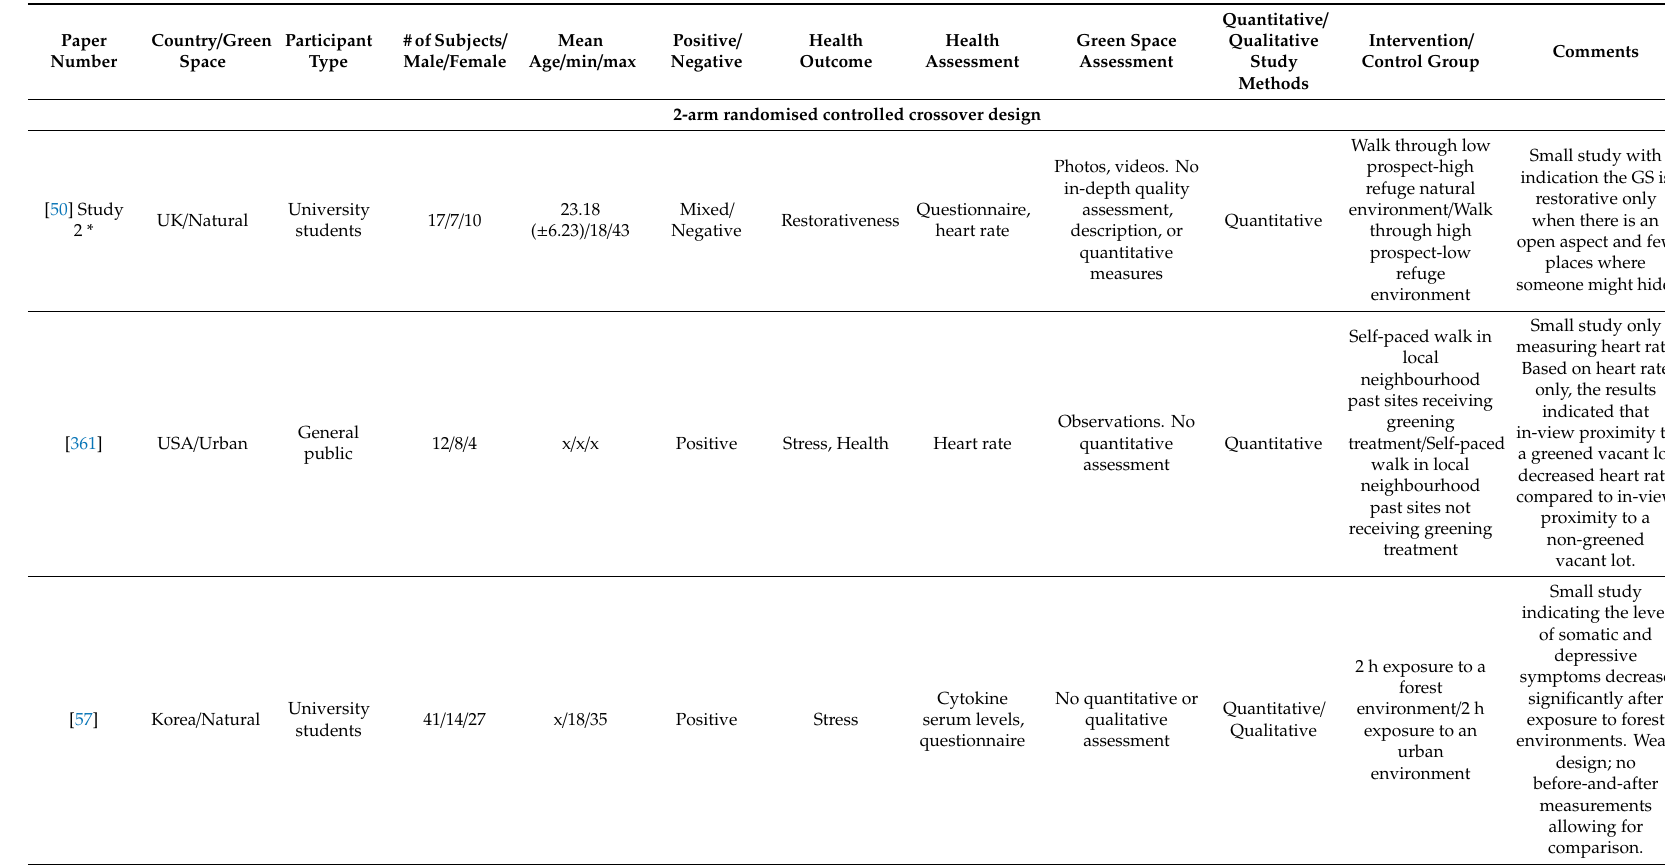
Table 10. Randomized controlled trials investigating the e ff ects of GS on mental